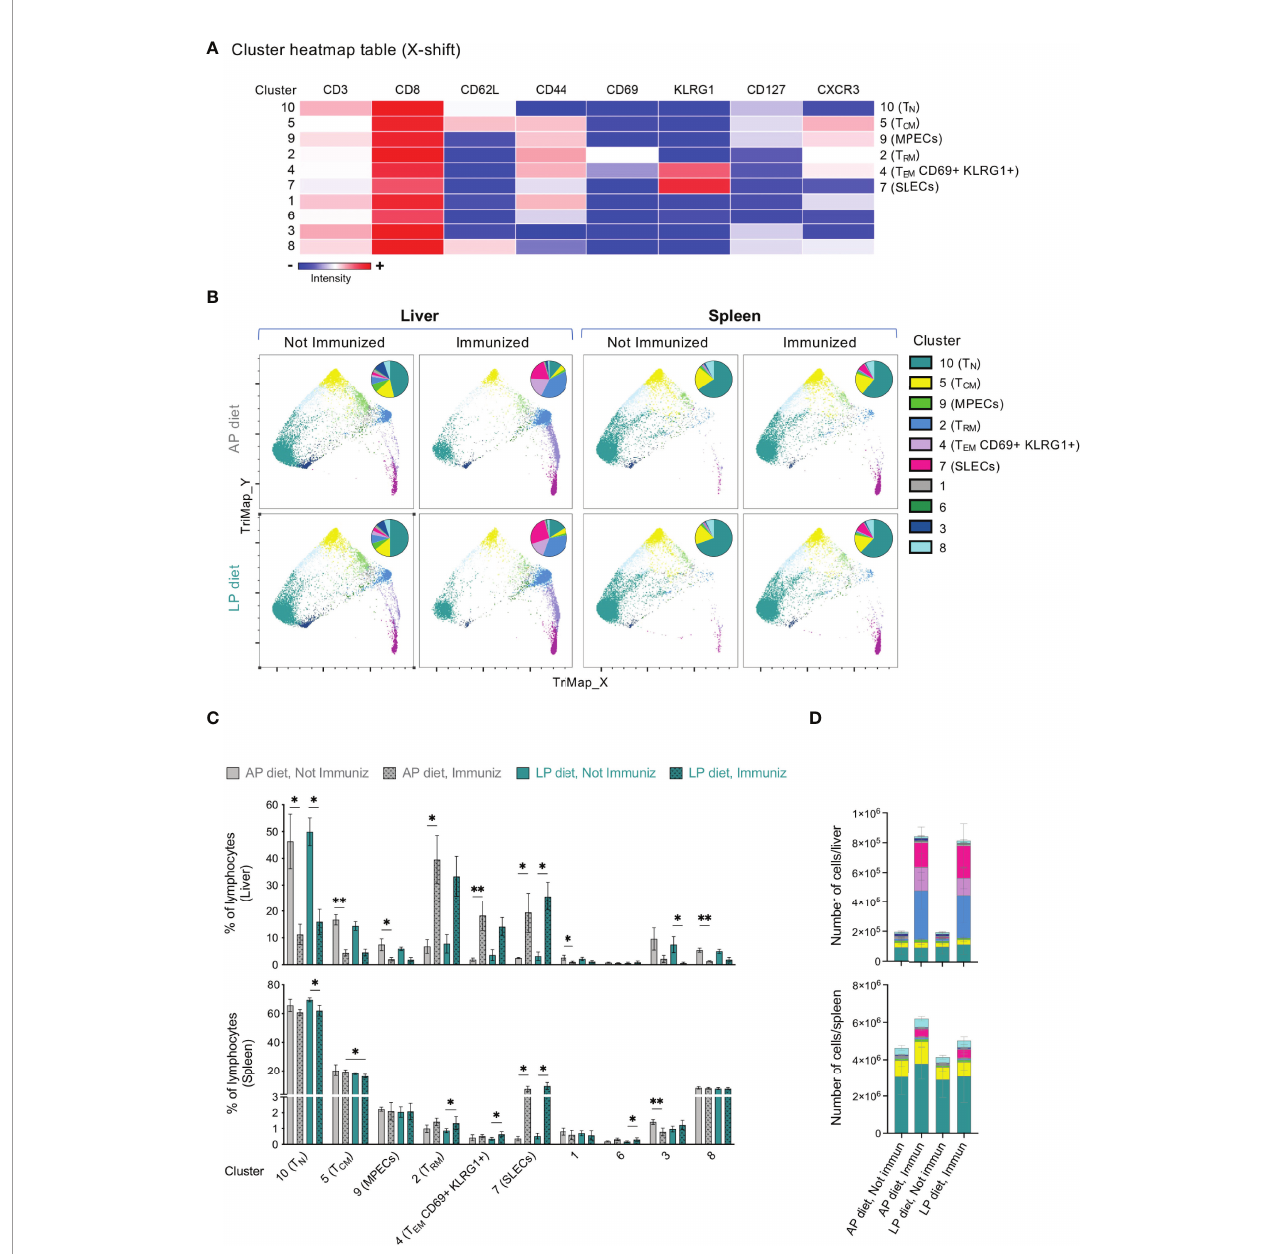
FIGURE 4 | Clustering analysis of the CD8+ T cell pool in the liver and spleen of mice under AP or LP diet. (A) Heatmap table of the clusters identi fi ed by X-shift analysis of concatenated data from CD8+ T cells of the liver and the spleen of non-immunized or RAS-immunized mice under AP or LP diet on the day of the infection/challenge (day 35). T N : naïve T cells; T CM : central memory T cells; T EM : effector/effector memory T cells; T RM : resident memory T cells; SLECs: short-lived effector cells; MPECs: memory-precursor effector cells; KLRG1: killer cell lectin-like receptor subfamily G, member 1. (B) X-shift clustering analysis of concatenated data from the liver or spleen of mice under each condition. Data is presented using TriMap dimensionality reduction. The inserts in each plot represent the distribution of the clusters within the CD8+ T cell population of each condition. Frequency (C) or numbers (D) of each of the clusters identi fi ed in the X-shift analysis in (A) in the liver or spleen, for each condition. Data are presented as mean ± SD and were compared using the Kruskal-Wallis test with Dunn ’ s multiple comparison post-test, with selection of the following pairs: AP diet Not Immunized (NImm) vs. AP diet Immuniz (Imm), LP diet NImm vs. LP diet Imm, AP diet NImm vs. LP diet NImm and AP diet Imm vs. LP diet Imm (*P < 0,05; **P <